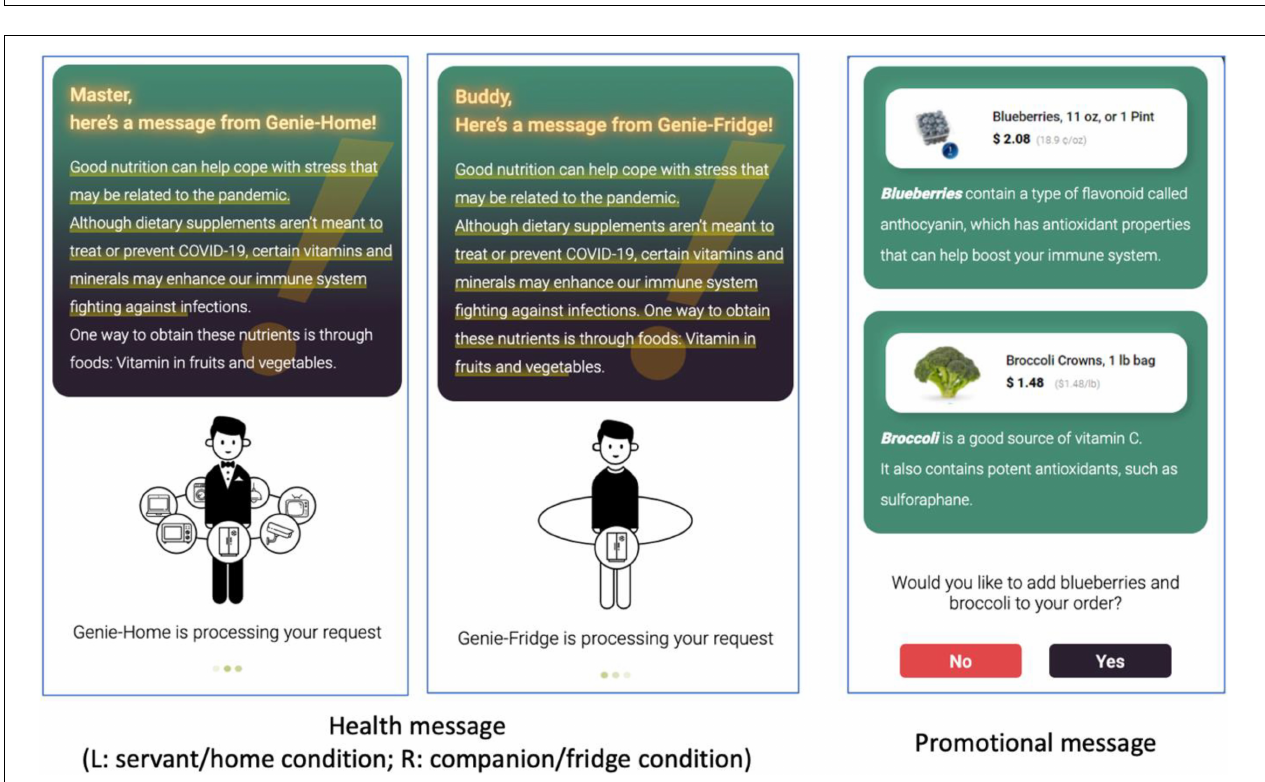
FIGURE 2 | Persuasive components of IoT mobile